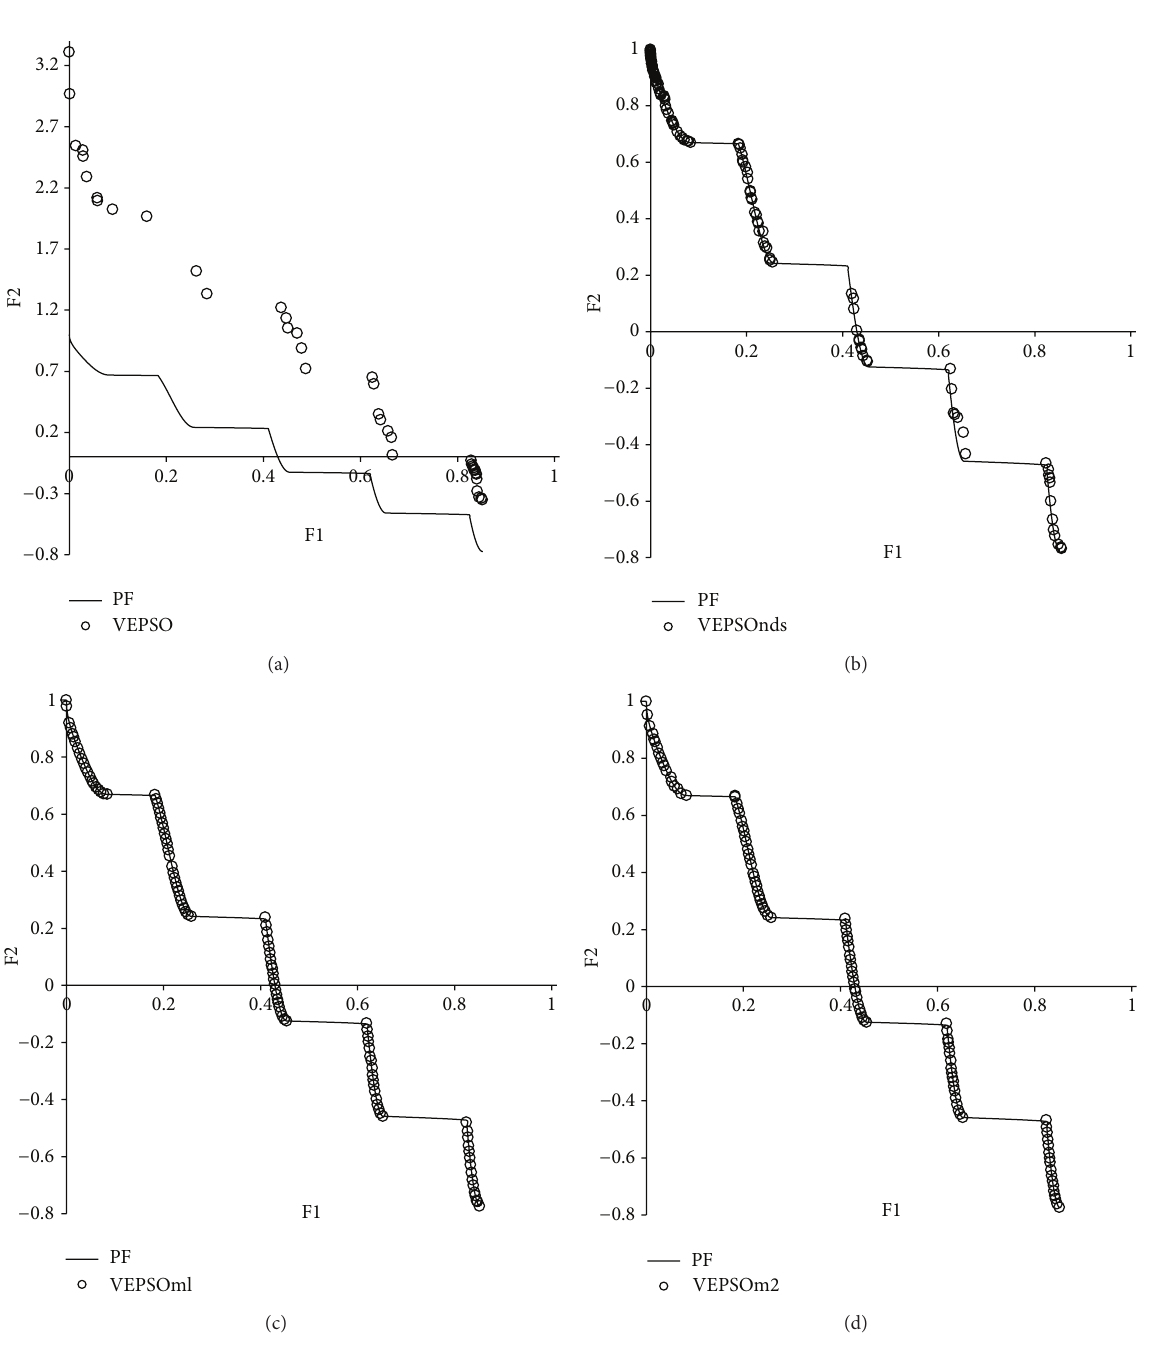
Figure 8: Plot of nondominated solutions returned by each algorithm for the ZDT3 test